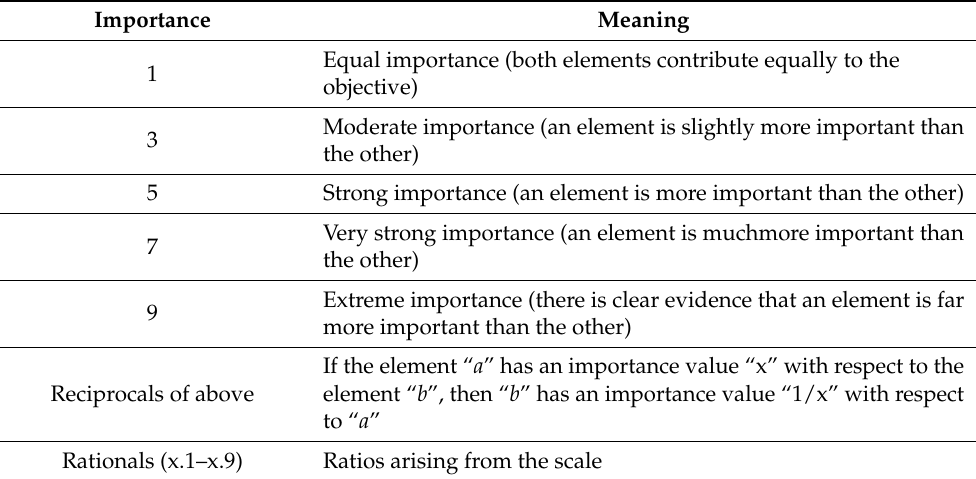
Table 2. Saaty’s scale of preference for the comparison of two elements (based on [42]). Importance Meaning Equal importance (both elements contribute equally to the